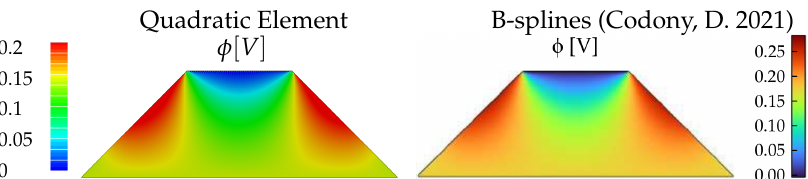
Figure 30. Contour plots of the electric potential φ in the truncated pyramid by [16,35] vs. the use of the developed quadratic element. The color scale for the contour of the quadratic element is adjusted for a higher contrast image.